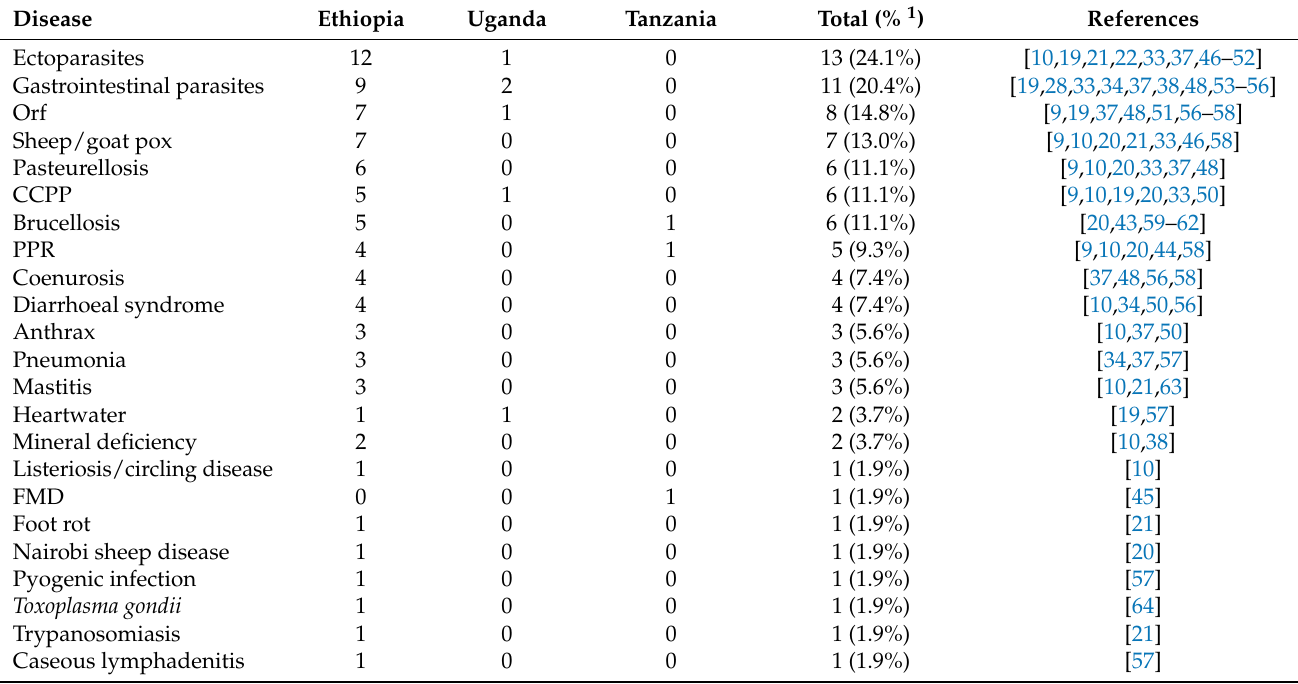
Table 2. Number of articles mentioning each disease as a constraint to small ruminant production.